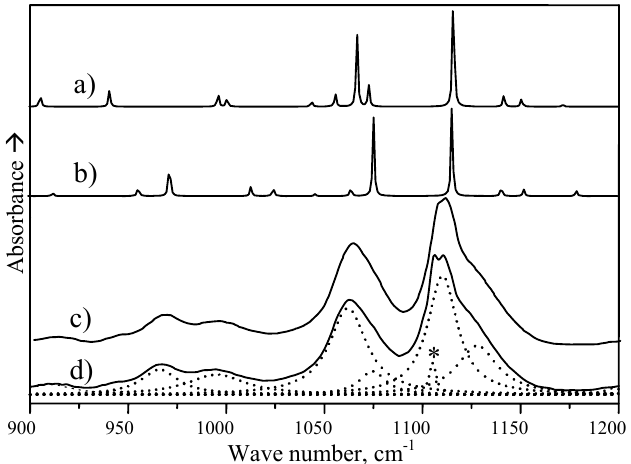
Fig. 8 IR absorption spectra of 1-heptene SOZ in spectral region of the ring vibrations: a) theoretically (B3LYP 6-311++G(3df, 3pd)) calculated spectrum of 1-heptene SOZ gauche conformer; b) theoretically calculated spectrum of 1-heptene SOZ anti conformer, c) and d) experimental spectrum of gaseous sample at 250 and 295 K